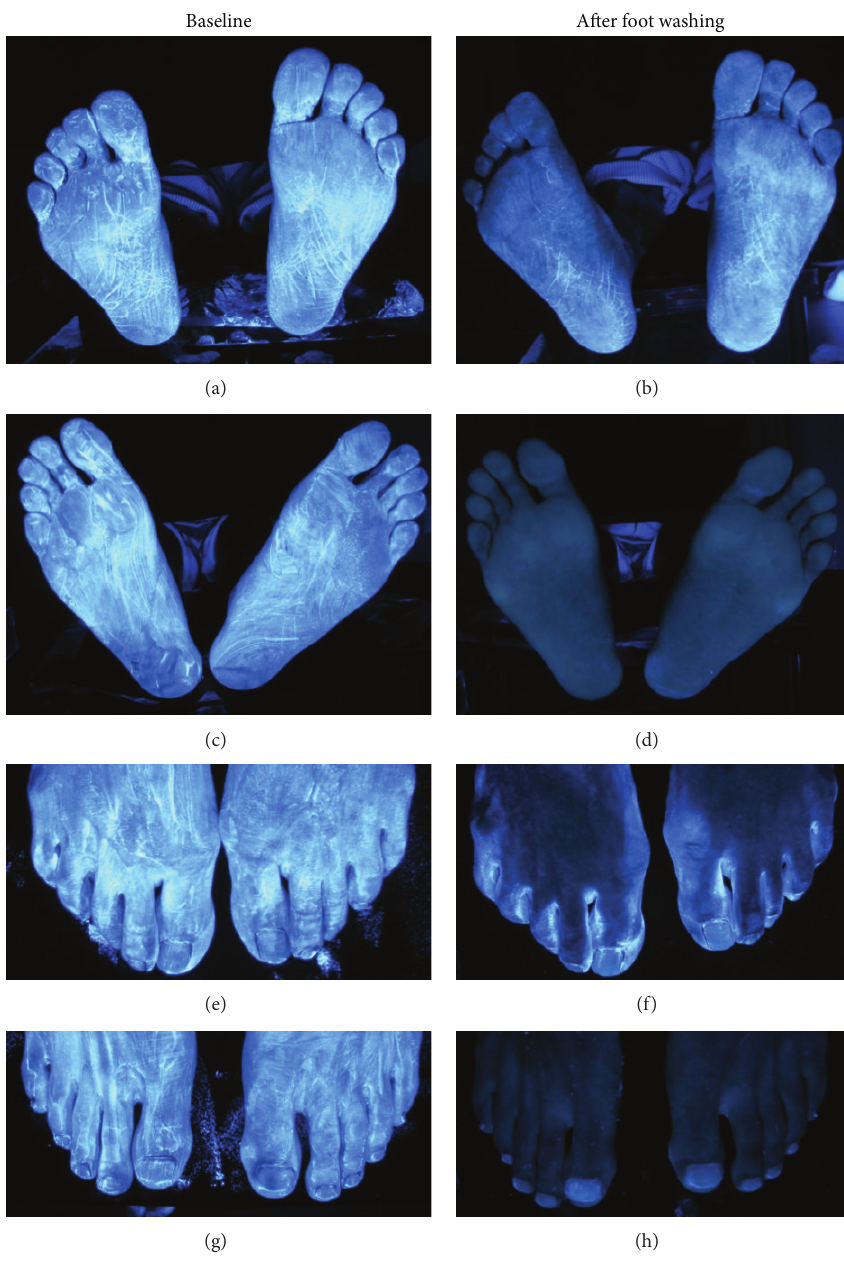
Figure 1: Representative images of patients’ feet from both study groups under ultraviolet light before and after foot washing. The blue- white fluorescent areas indicate the presence of fluorescence from the residual cream, and the bluish-black areas represent the absence of fluorescence. (a) The soles of the participant’s feet are infected with tinea pedis (TP) before foot washing. (b) The soles of the same participant’s feetafterfootwashing.Thefluorescenceintensityreductionrate(FIRR)is34.9%.(c)Thesolesoftheparticipant’sfeetdonotshowTPinfection beforefootwashing.(d)Thesolesofthesameparticipant’sfeetafterfootwashing.TheFIRRis88.6%.(e)Areasbetweenthetoesofaparticipant with TP before foot washing. (f) Areas between the toes of the same participant after foot washing. This participant has residual cream. (g) Areas between the toes of a participant without TP infection before foot washing. (h) Areas between the toes of the same participant after foot washing. This participant has no residual cream. The nails are showing